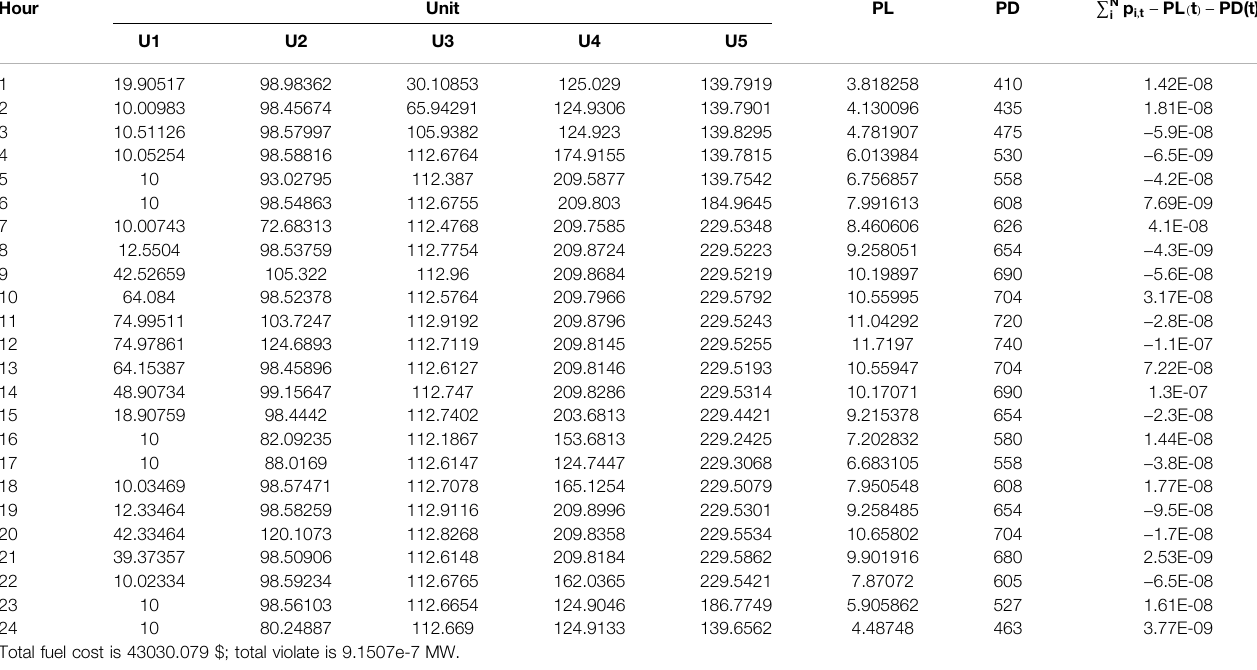
TABLE 10 | The optimal solution information for Case I : only 5-unit power system.